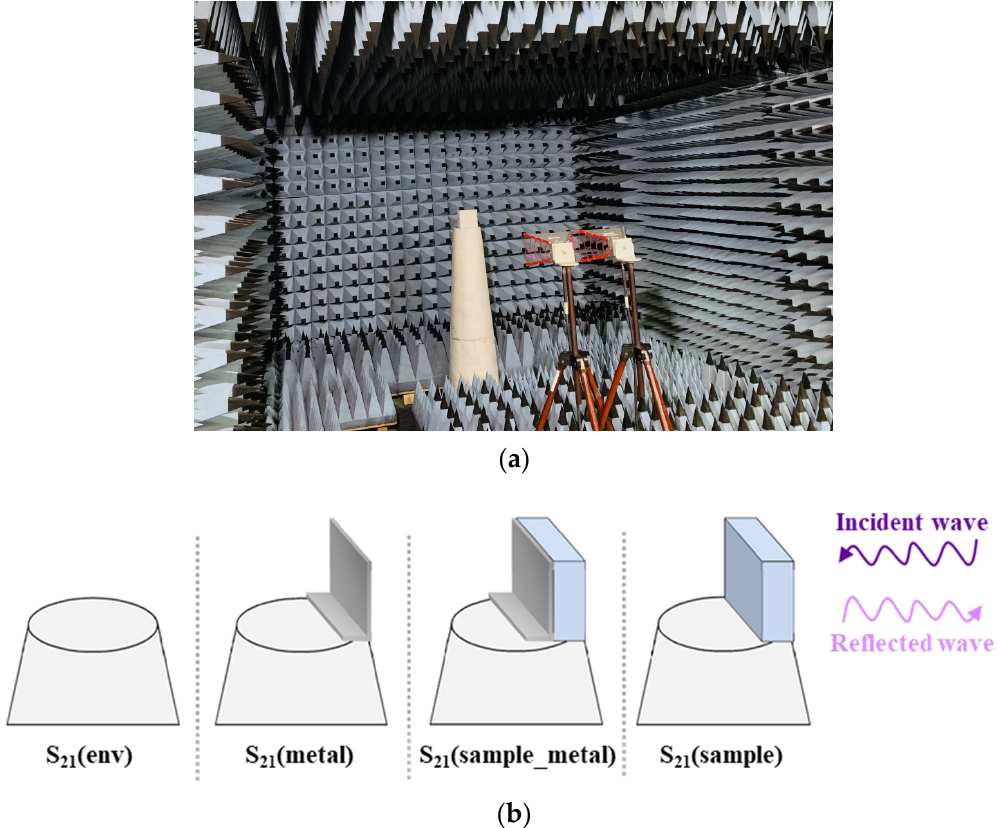
Figure 2. Measurement configurations ( a ) in the anechoic chamber and ( b ) of the four different S 21 parameters.